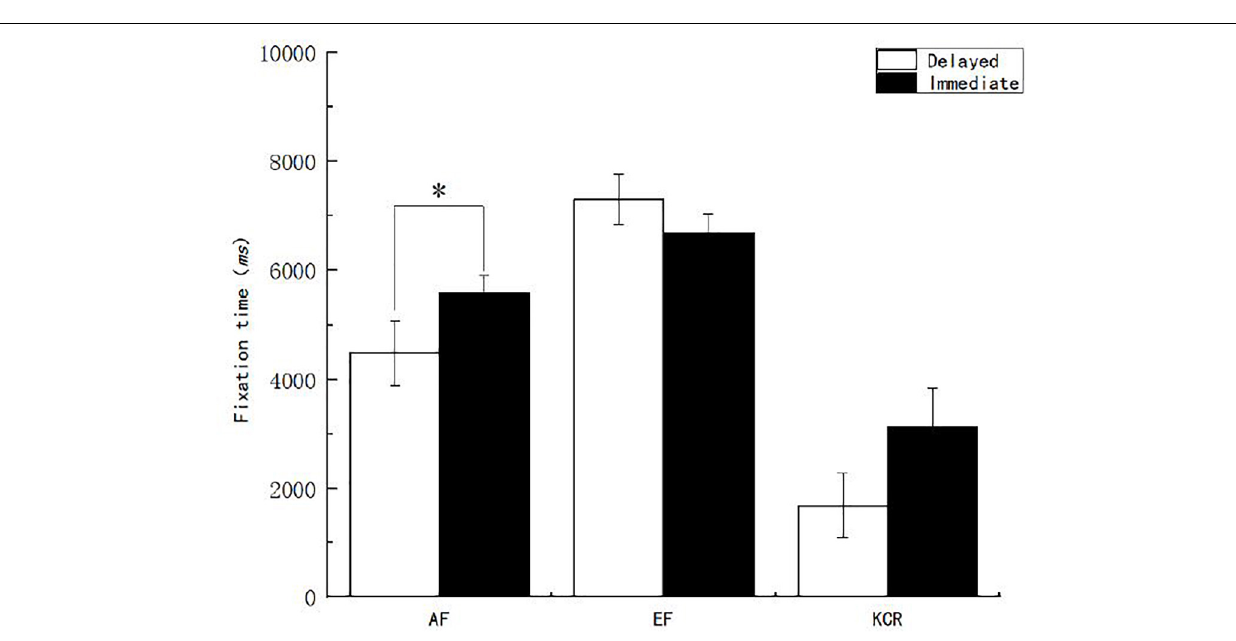
FIGURE 8 | Learners’ fixation time on the feedback interest area under different feedback conditions. *Significant correlation at the level of 0.05